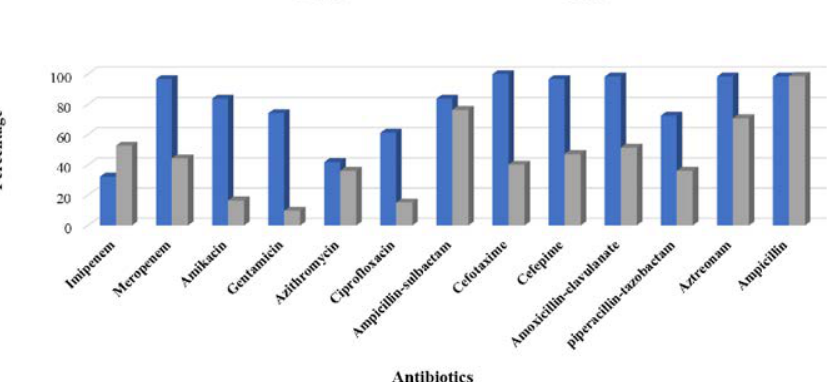
Fig. 4. Resistance pattern of the isolated Gram-negative bacteria before and after the